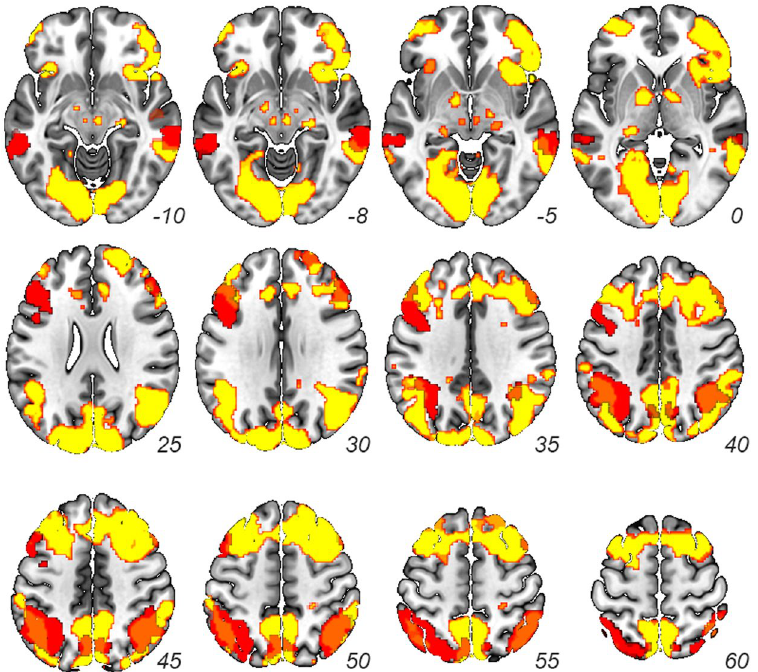
Figure 2. Repetition Suppression. Results from whole-brain contrast of out-group/in-group trials > identical in-group, different in-group trials (red; p < 0.001 corrected from p < 0.005) overlaid on top of resulting FPCN map resulting from (45) (yellow). Orange denotes overlap between the two maps.